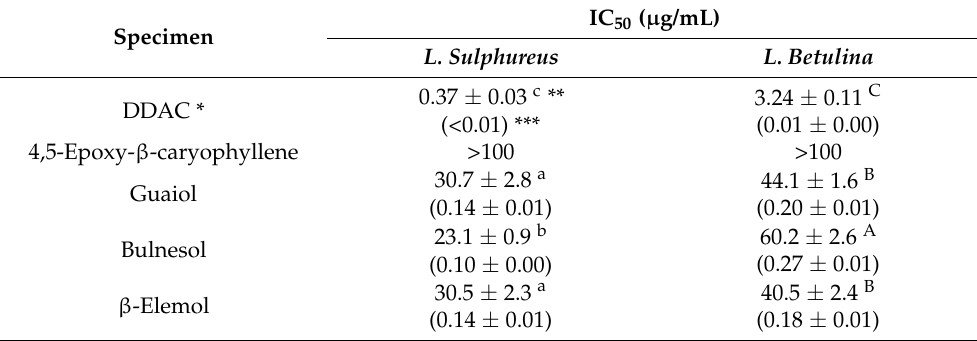
Table 2. IC 50 values of compounds from leaf essential oil against wood-rotting